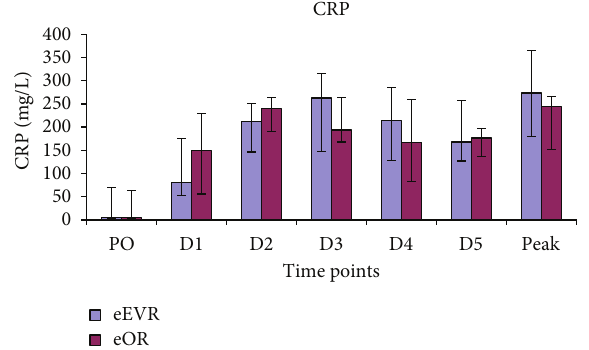
Figure 4: Serum CRP concentrations expressed as median and interquartile range.